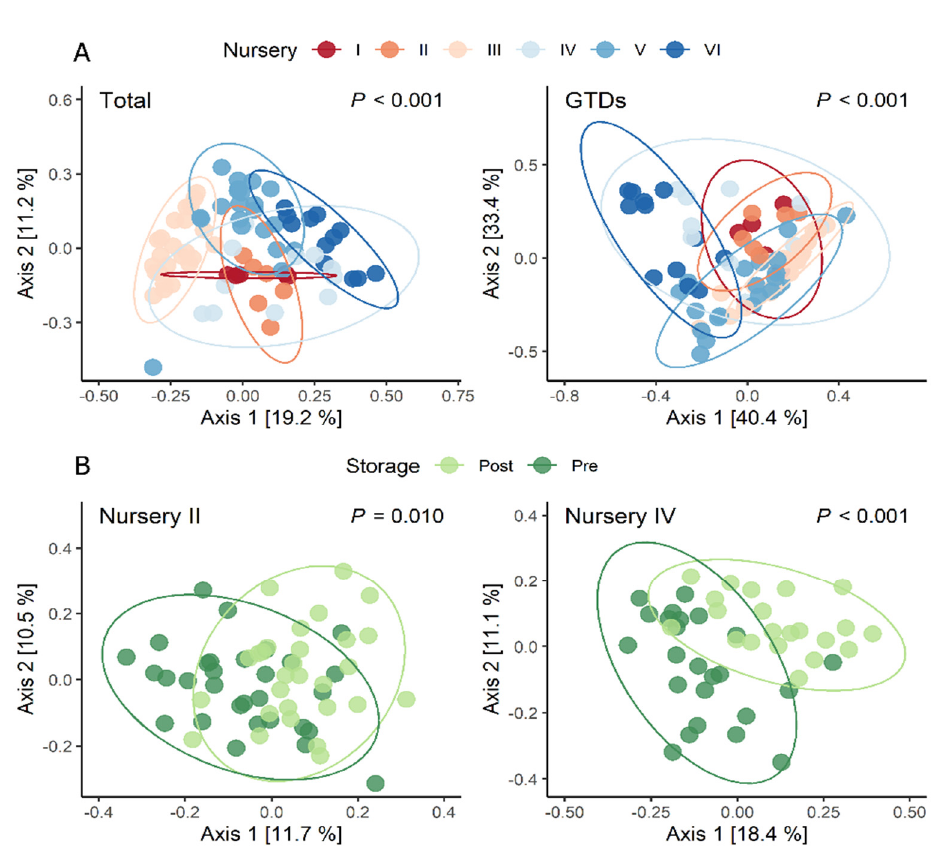
Figure 6. Representative examples of the degree of variation between nurseries within varieties, and of the degree of variation of storage between nurseries influencing total fungal community and GTD-related fungal community composition. ( A ) Variation in Macabeu plantings across nurseries. ( B ) Effect of storage in nurseries II and IV before (pre; dark green) and after (post; light green) storage. The figure shows a PCoA ordination calculated with a bray-distance matrix. The R 2 and p -values shown are extracted from a PERMANOVA analysis performed with the adonis2 function in R, in which all design variables are included.